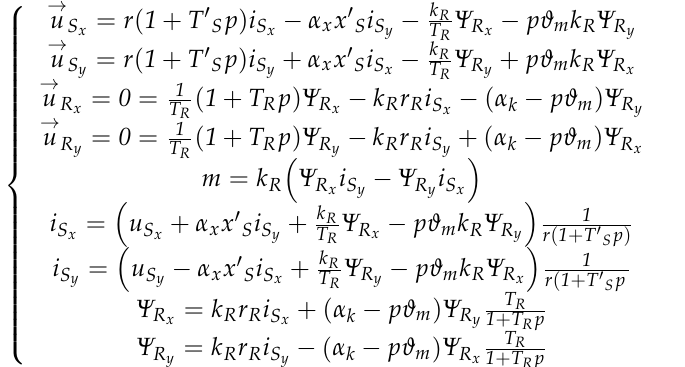
Figure 5. Algorithm of the control system operation for the buffer source of electricity. If the rectifier voltage is below the nominal voltage preset in the control system, the key that connects the buffer power supply system based on supercapacitors is closed— Figure 6, red signal. As a result, the rectified supply voltage is connected in series with the